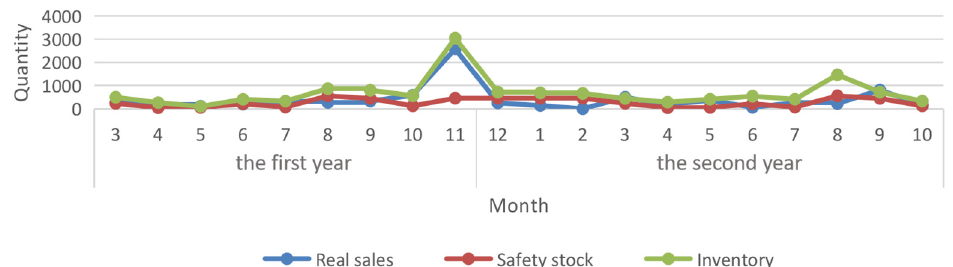
Figure 6. Comparison of real sales data with monthly safety stock and inventory levels.